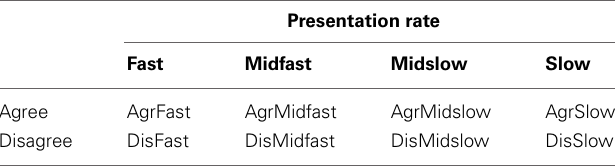
Table 1 | Experiment